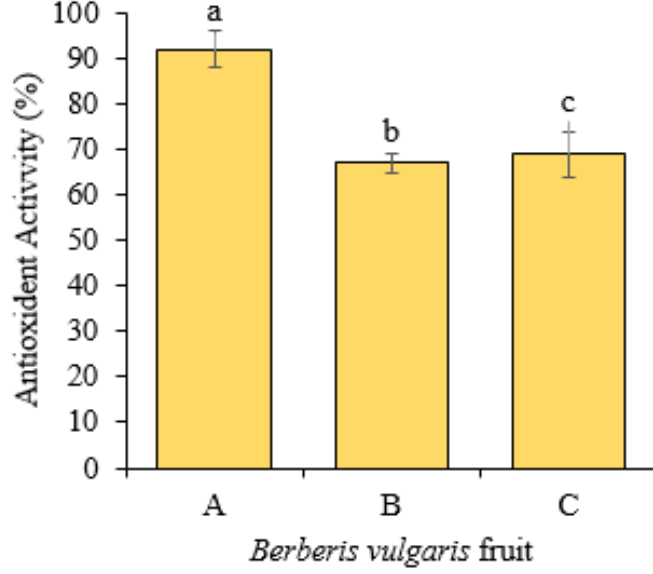
Figure 3. Antioxidant activity (%) of Berberis vulgaris fruits collected from A: Jilin province, B: Heilongjiang province and C: Liaoning province. Each value is a mean of five replicates ± SD. Similar lettering shows no significant difference according to LSD test.